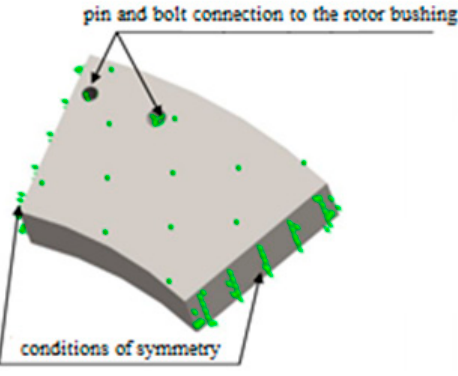
Figure 15. Conditions of the disc fastening.